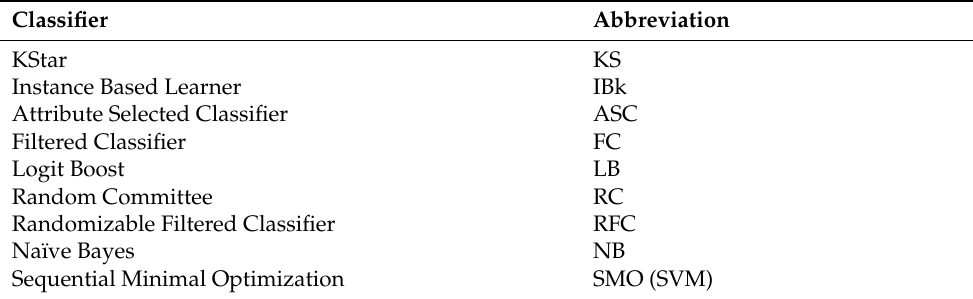
Table 4. Classifier names and their